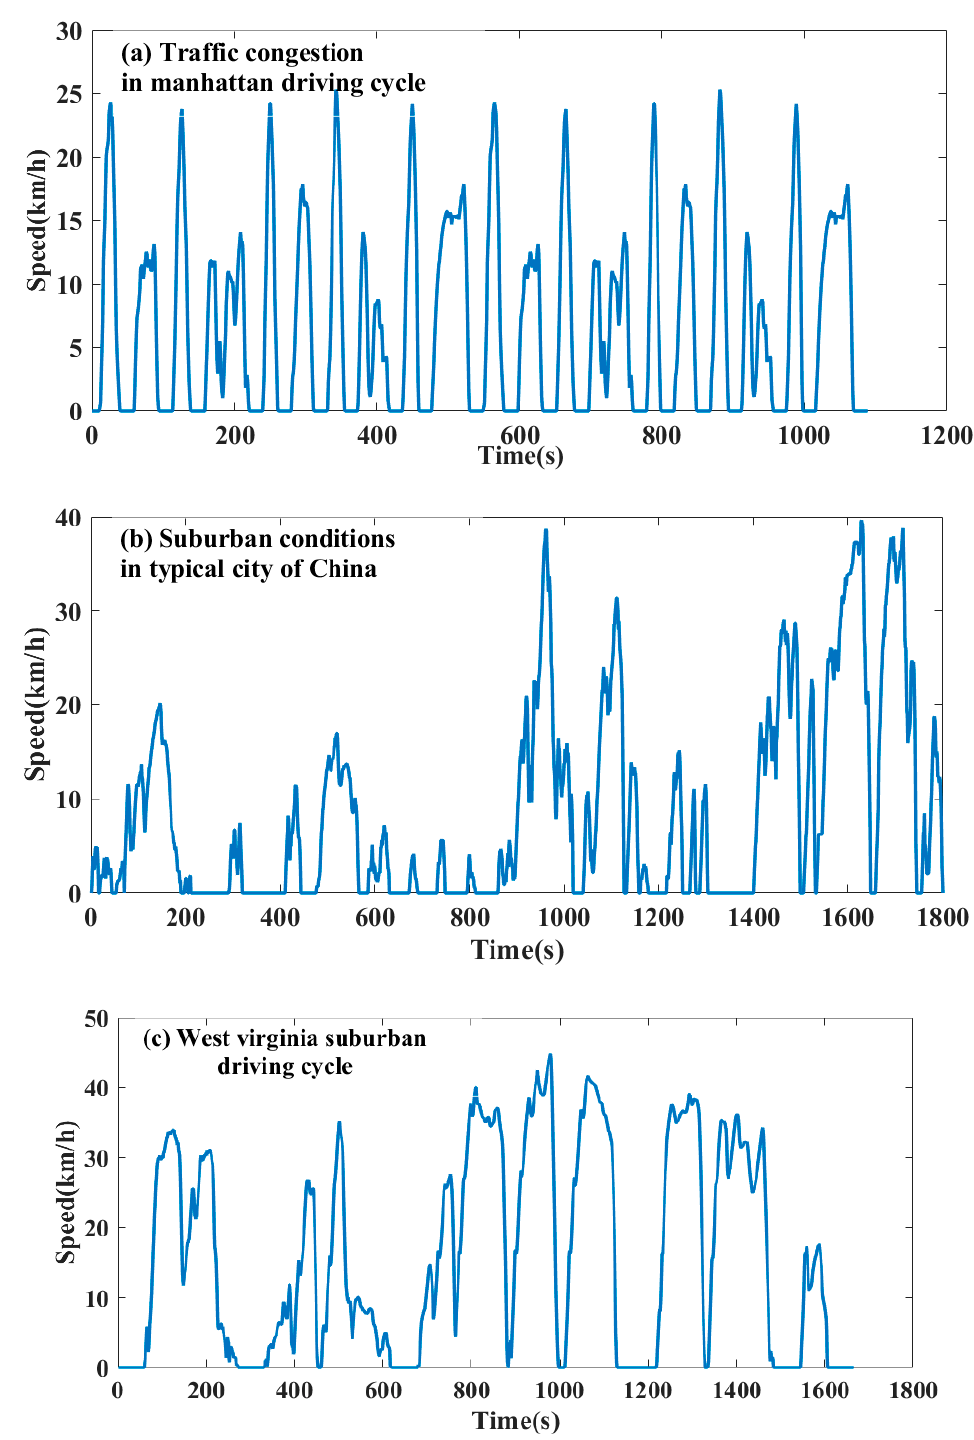
Figure 6. Three driving cycles.